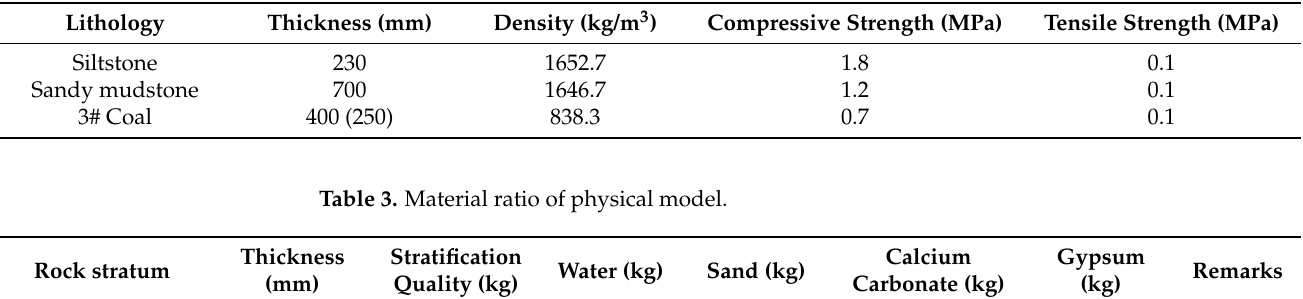
Table 2. Thickness and mechanical parameters of physical model